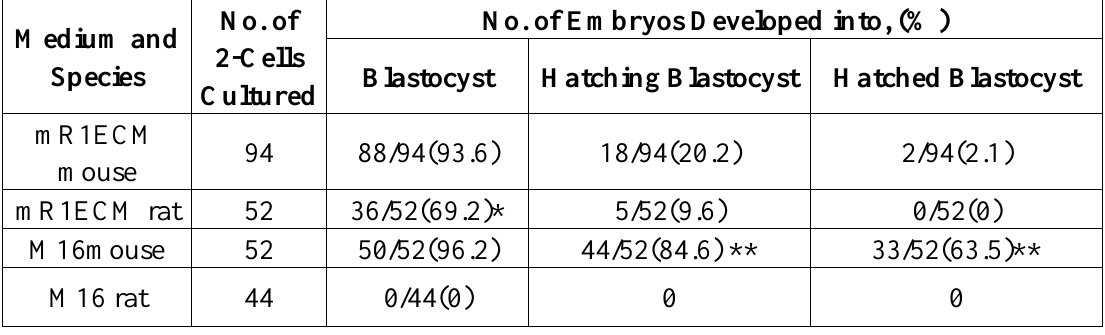
Table 3 . In vitro development of mouse and rat 2-cell stage embryos in various mediums. Medium